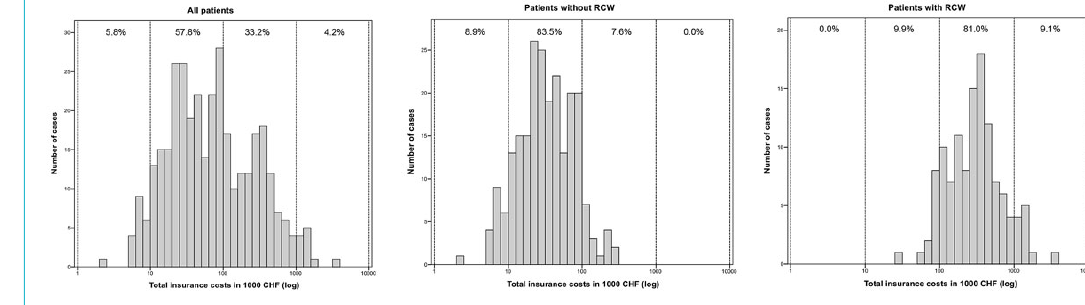
Figure 3: Total insurance costs for patients: All patients and subgroups with and without reduced capacity for work